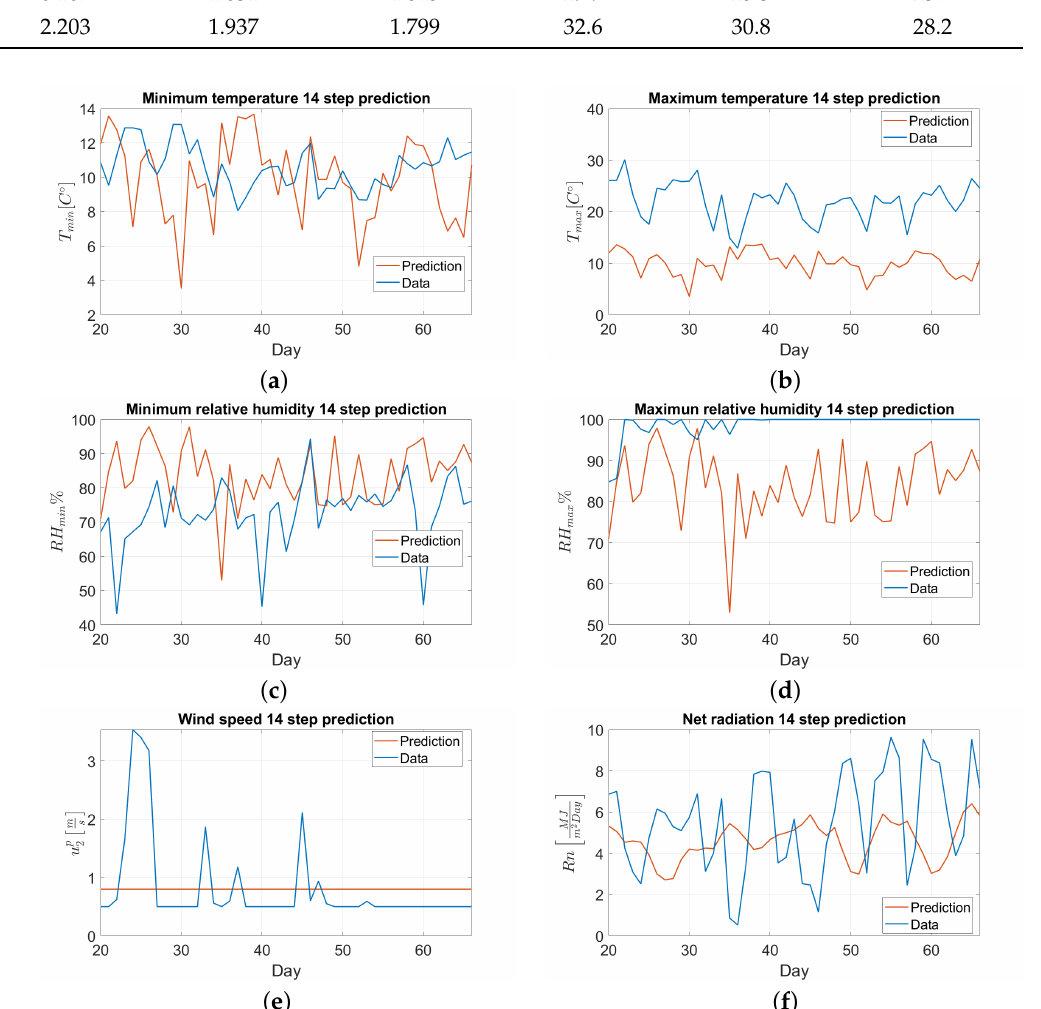
Figure 5. Fourteen-day predictions of all the climate variables considered for medium-term climate prediction in the greenhouse. The data considered here correspond only to a simulation using the winter data. In each graph, the blue line represents the simulated data , and the red line shows the corresponding predictions. The predictions were output once per day. ( a ) Minimum greenhouse temperature T min ; ( b ) maximum greenhouse temperature T max ; ( c ) minimum greenhouse relative humidity RH min ; ( d ) maximum greenhouse relative humidity RH max ; ( e ) greenhouse wind speed u p ( f ) net radiation in the greenhouse R n